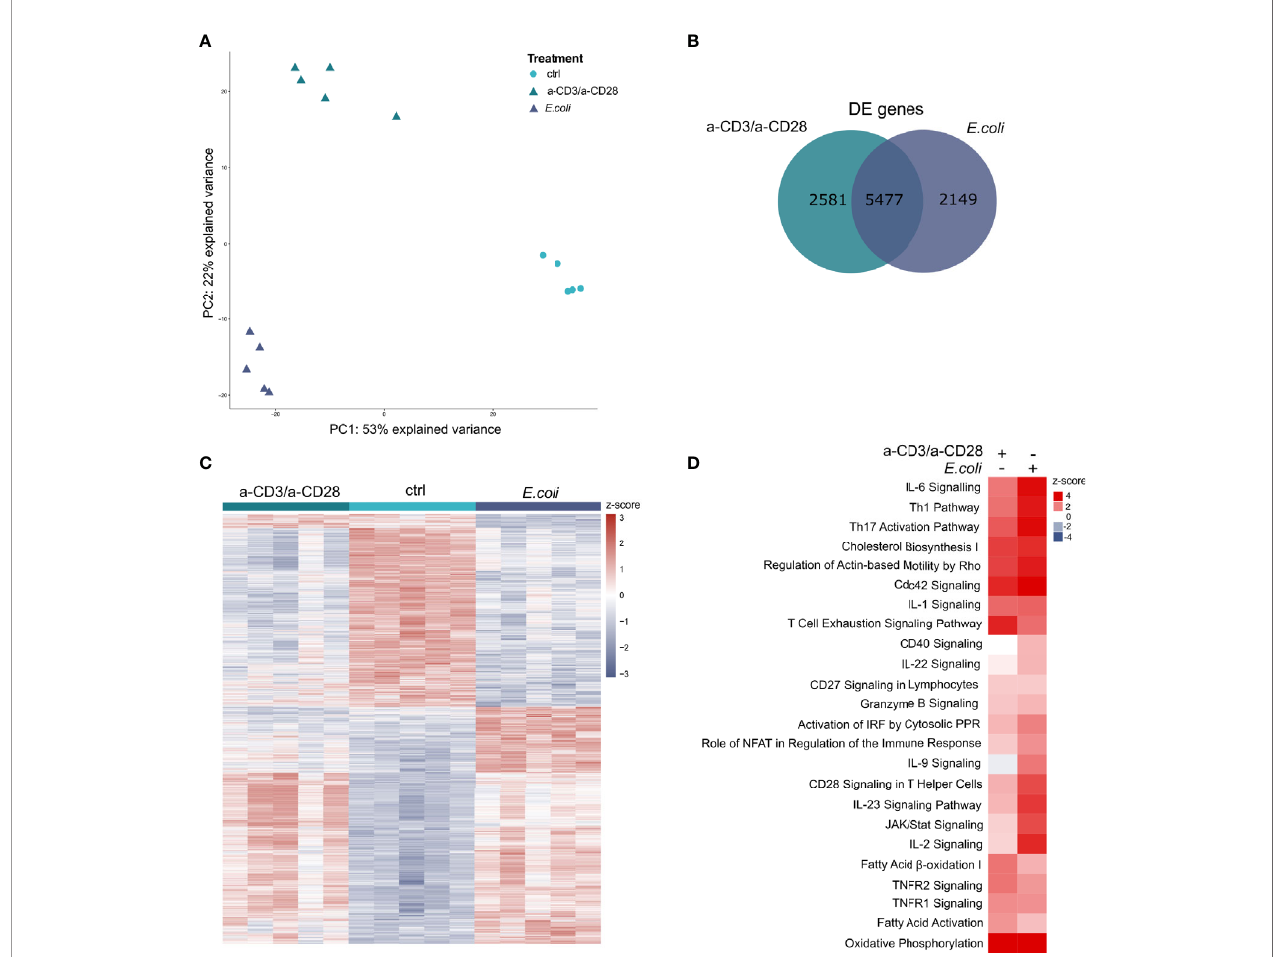
FIGURE 2 | Transcriptomic pro fi ling of activated human MAIT cells (A) Principal component analysis of activated MAIT transcriptomes. Each symbol represents one donor (n=5). (B) Overlap of totally expressed and differentially expressed genes (p.adj ≤ 0.01) in MAIT cells stimulated either with E. coli -pulsed monocytes or anti- CD3/a-CD28 antibodies or left untreated (ctrl). (C) Hierarchical clustering and heatmap of differentially expressed genes. (D) Enriched core pathways of DE genes (p.adj ≤ 0.01) during MAIT cell activation determined by IPA (p.adj ≤ 0.05,